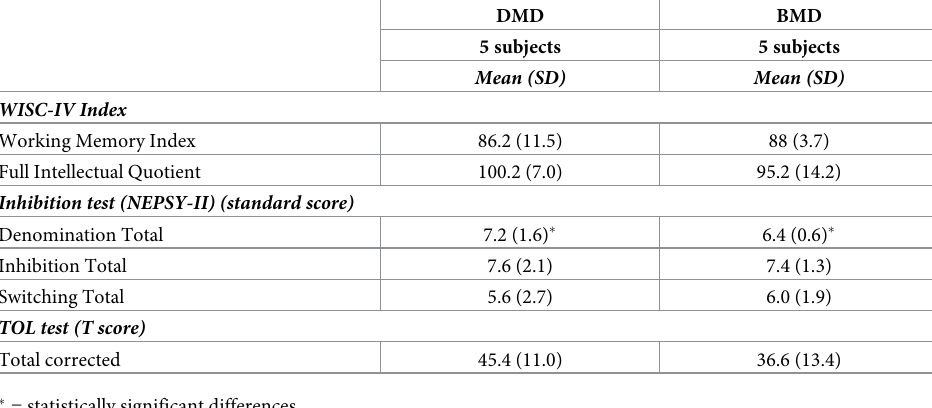
Table 1. Intellectual and executive functioning in DMD and BMD